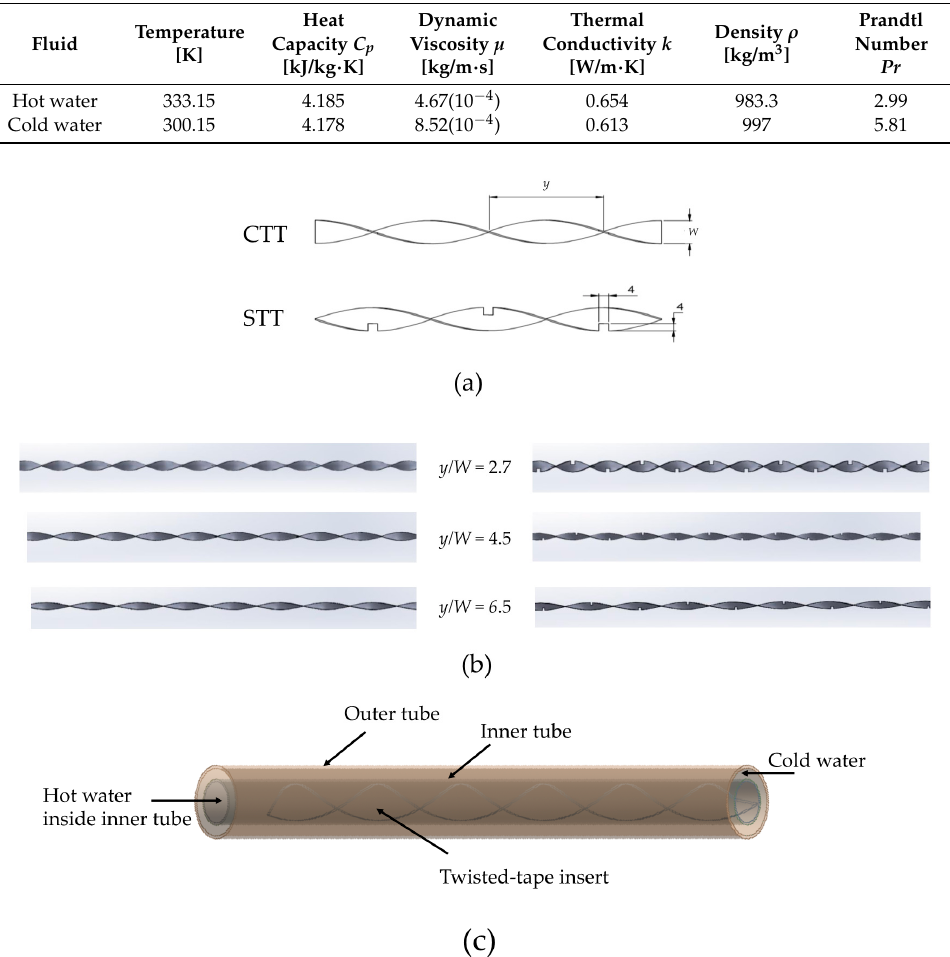
Figure 1. Schematic of the tube with inserts: ( a ) nomenclature of CTT and STT; ( b ) CTTs and STTs with twist ratio variation; ( c ) computational domain under the present